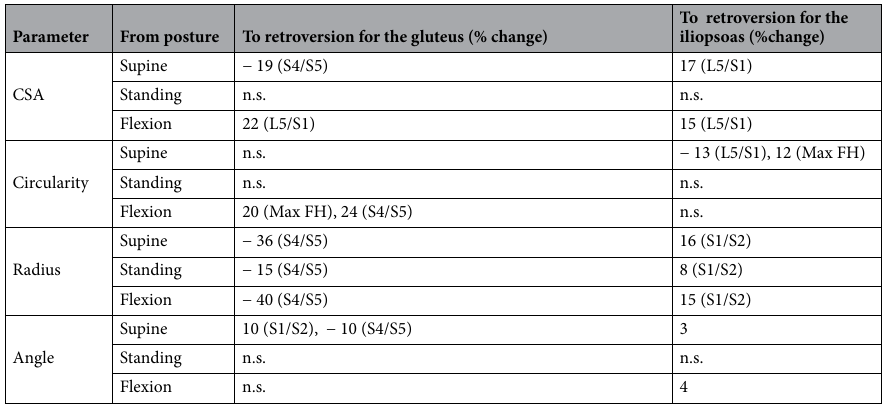
Table 5. Summary table of significant effects of retroversion posture on gluteus and iliopsoas parameters (P < 0.05, Neuman-Keuls significant). Percent change in parameter is listed, in some cases at a particular level as indicated in the brackets. (n.s. = non significant, − =